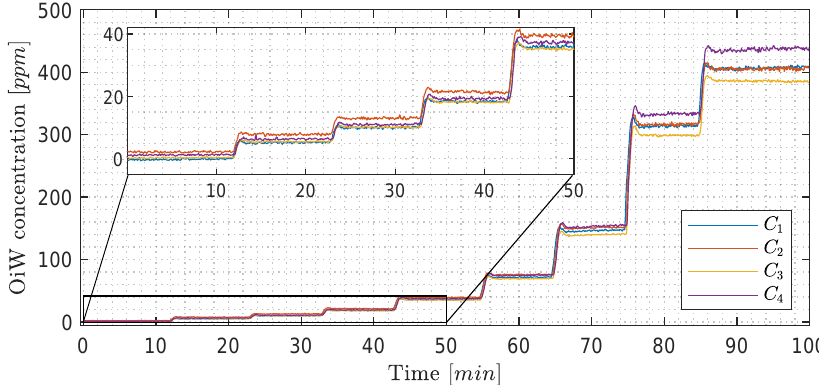
Figure 16. Similar as Figure 15; however, the measurements from the four OiW monitors are based on the WLS calibration method instead of OLS.